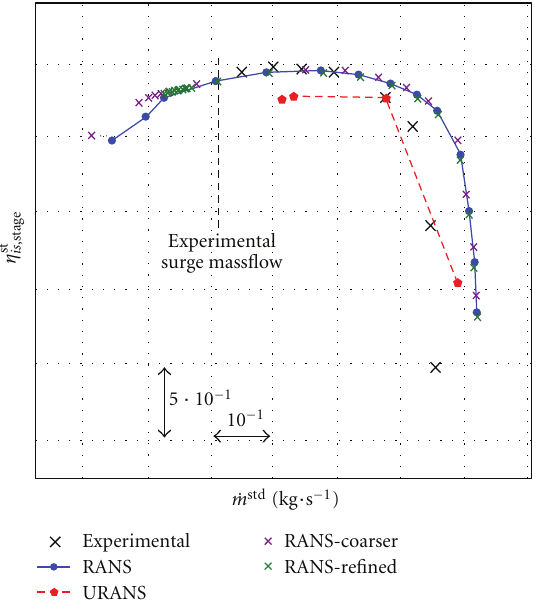
Figure 3: Total-to-static compressor stage isentropic e ffi ciency.